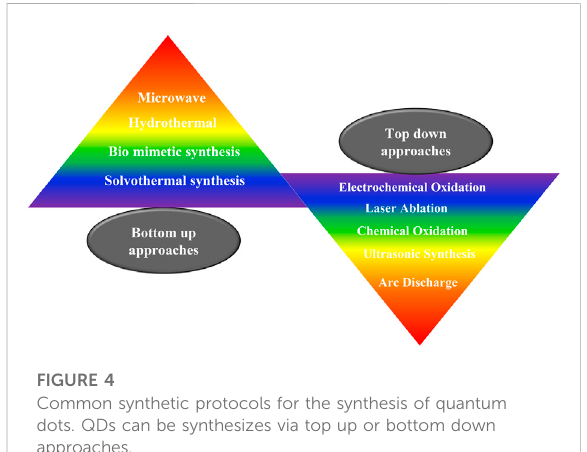
FIGURE 4 Common synthetic protocols for the synthesis of quantum dots. QDs can be synthesizes via top up or bottom down